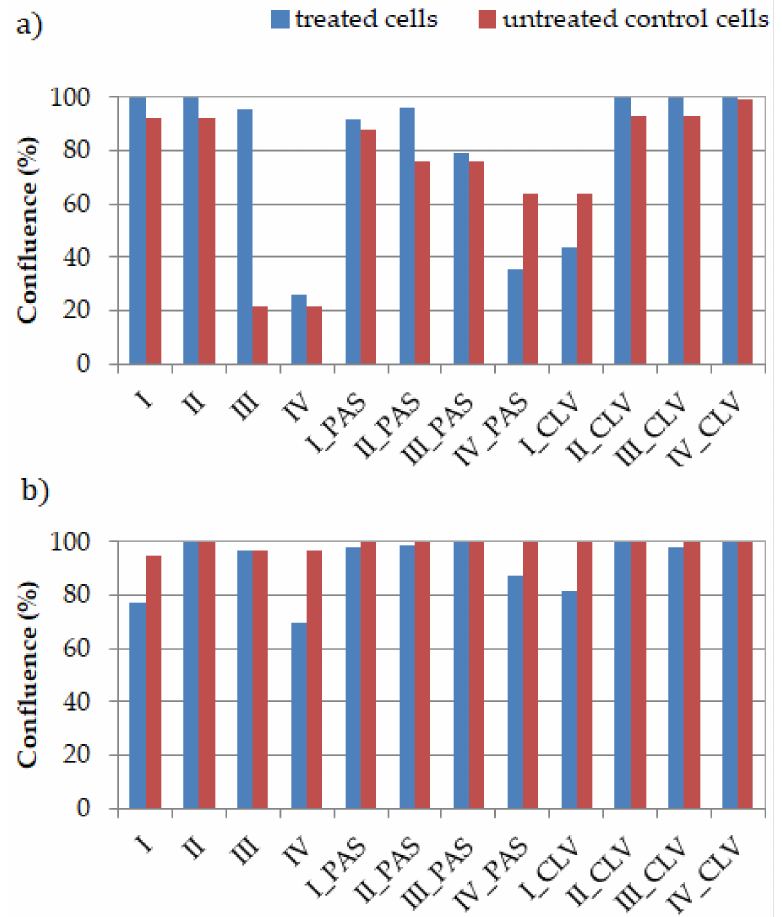
Figure 3. The confluence of polymer/conjugate (treated cells) in comparison to untreated control cells for ( a ) BEAS-2B and ( b ) A549 cell